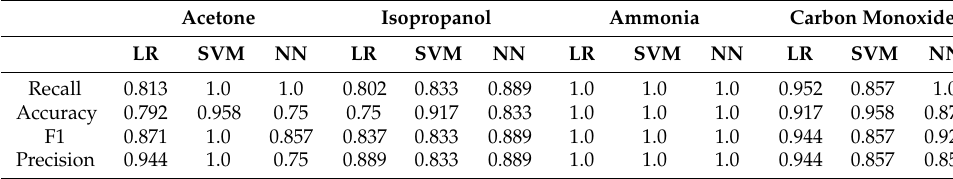
Table 2. Classification performance evaluations using 3-fold